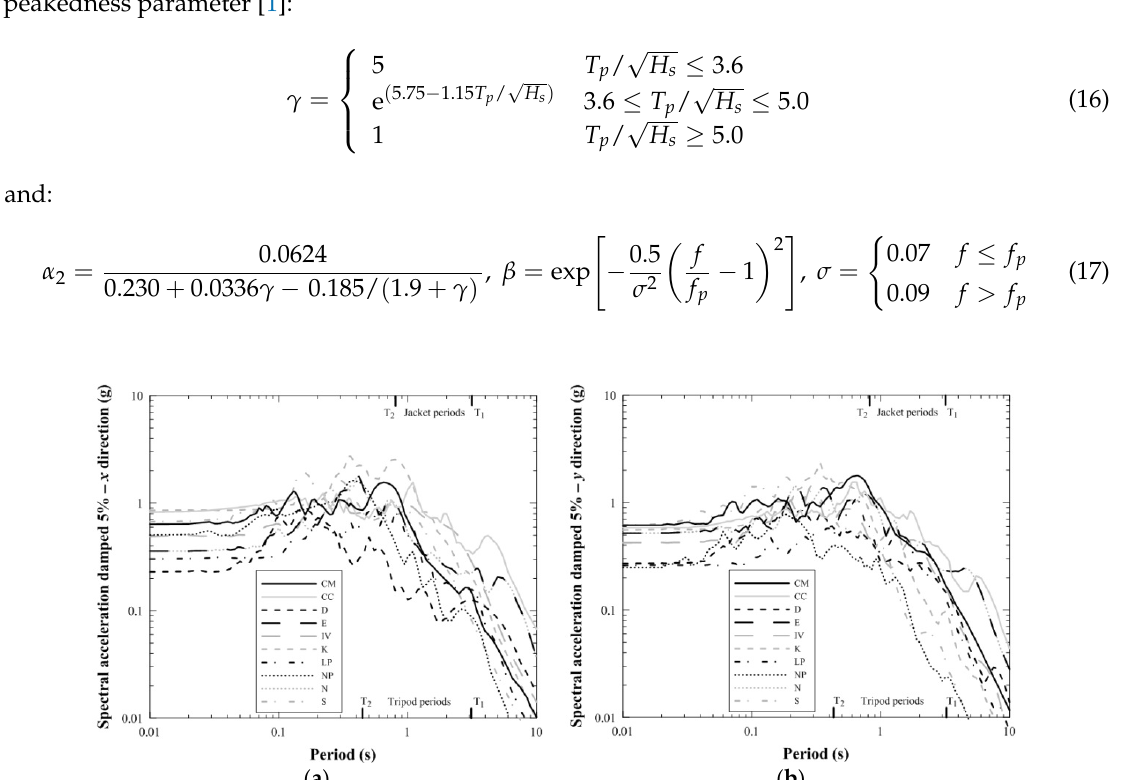
Figure 3. 5% damped spectral acceleration of earthquake records, as taken from ref. [43]; ( a ): x direction; ( b ) y direction.